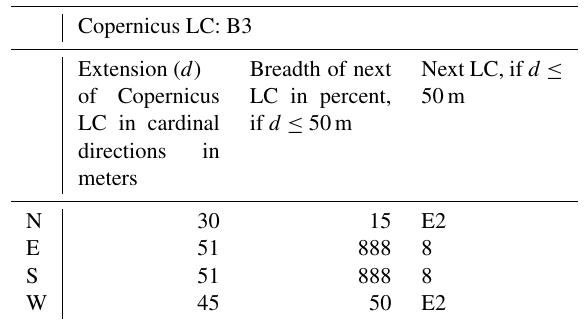
Table 2. Example of information collected by the Copernicus proto- col (for point with ID 45223358). The Copernicus protocol collects observations on 13 variables: land cover (LC) at LUCAS legend level 2 (here B3 is “non-permanent industrial crops”), the extension of the LC in the four cardinal directions (up to 50m, 51 means more than 50m), the breadth of the next LC in the four cardinal directions (%), and the next LC in the four directions (here, E2 means “grass- land without tree/shrub cover” in the N and W). Figure 1 shows how this information is used to build the geometries of the Copernicus polygon with homogeneous LC. The radial distance d is measured between the Copernicus point and the next LC, with “888” and “8” meaning “not